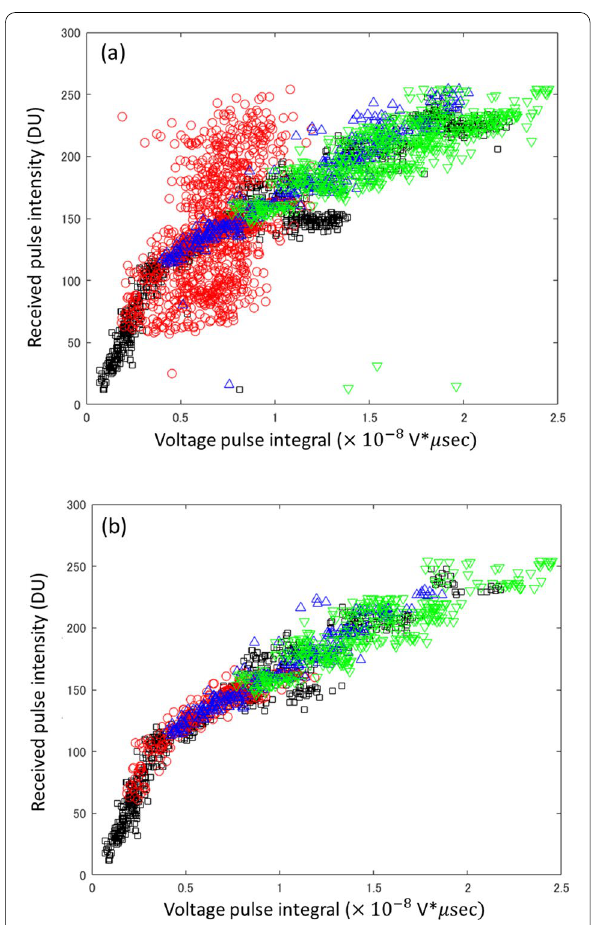
Fig. 6 D R and S v : a all measured pulses excluding D R pulses shorter than 90 ns. Black rectangles, red circles, blue upward triangles, and green downward triangles represent rectangular, gaussian, ascending triangular, and descending triangular pulses, respectively. The non-linear relation between the voltage pulse integral and received pulse intensity is likely due to the characteristics of the integration and peak-hold circuits of the